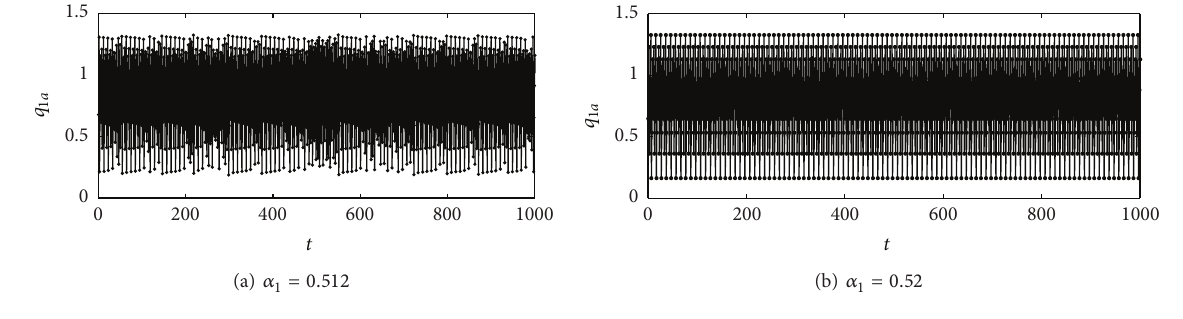
Figure 4: The time series of 𝑞 1𝑎